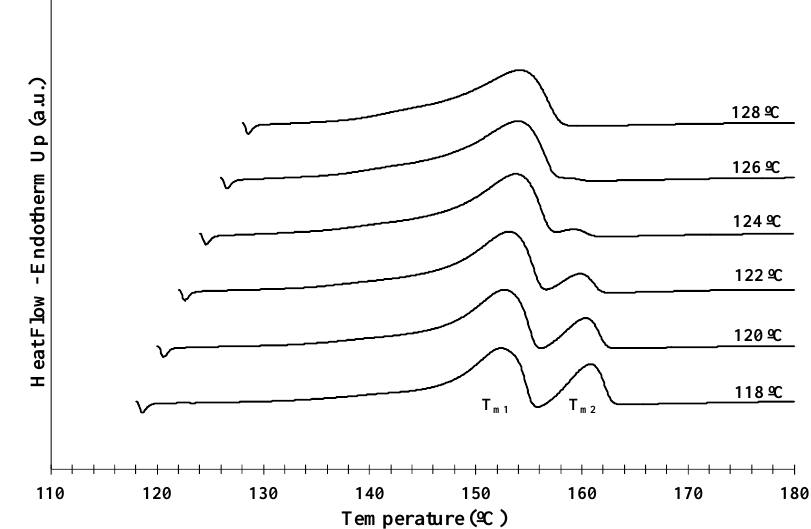
Figure 5. Melting DSC thermograms of PHBV/INT-WS 2 (1.0 wt. %) nanocomposite obtained at a heating rate of 5 °C min −1 after isothermal crystallization at the indicated temperatures.